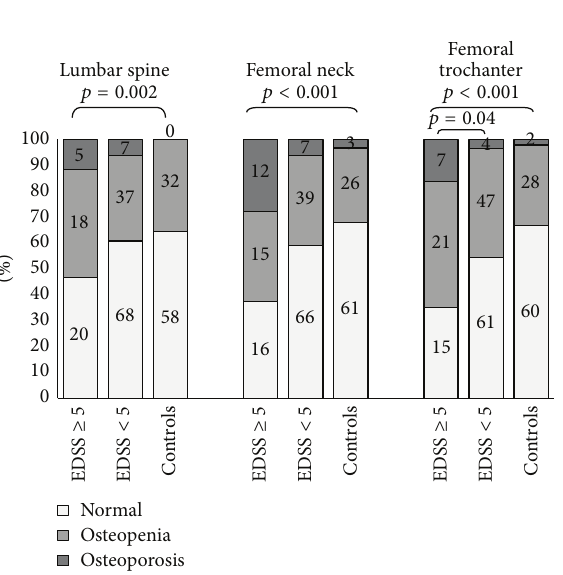
Figure 1: Count and proportions of patients and controls with WHO classified 12 osteoporosis ( 𝑇 -score ≤ −2.5 ), osteopenia ( −2.5 < 𝑇 -score ≤ −1.0 ), and normal ( 𝑇 -score > −1 ). 𝑝 value was calculated using 𝜒 2 test and refers to patients with osteopenia or osteoporosis in at least one site compared to controls. Count of the patients and controls in each group is shown on the